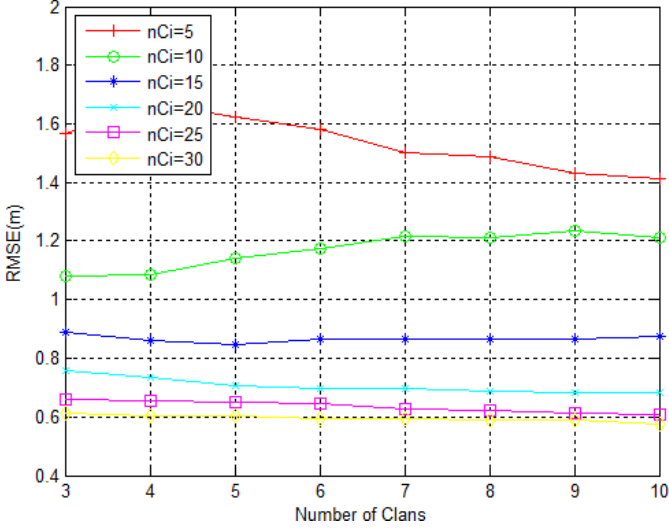
Figure 5. RMSE (m) dependency on the number of clans and n c